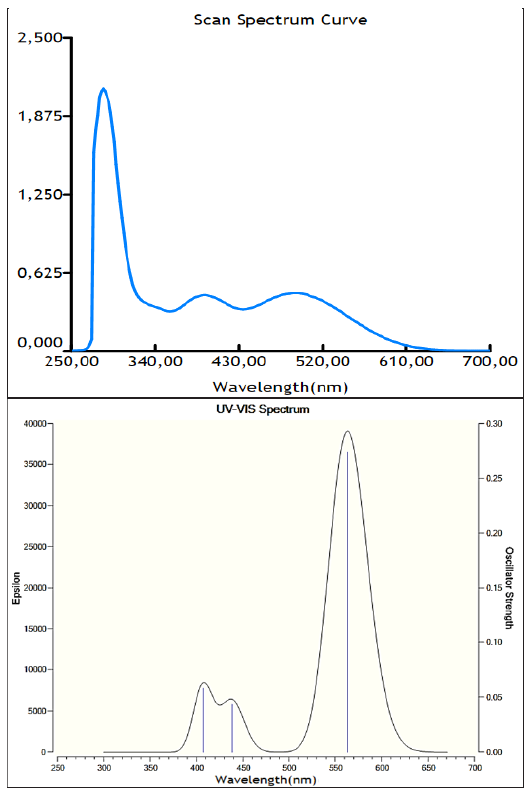
Figure 6: Experimental (above) and calculated (below) Uv-vis absorption spectra of the PINQ.